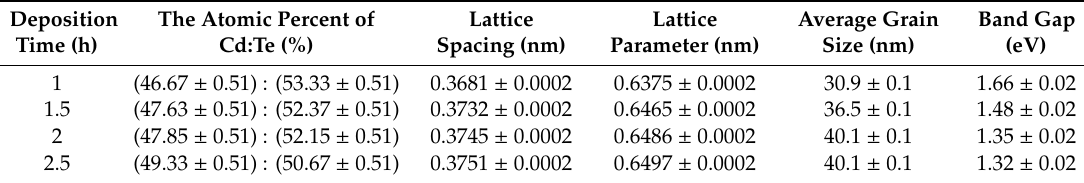
Table 1. The atomic percents determined by EDS, average grain sizes calculated from XRD data, and the band gaps calculated from UV-Vis diffuse-reflection spectra.